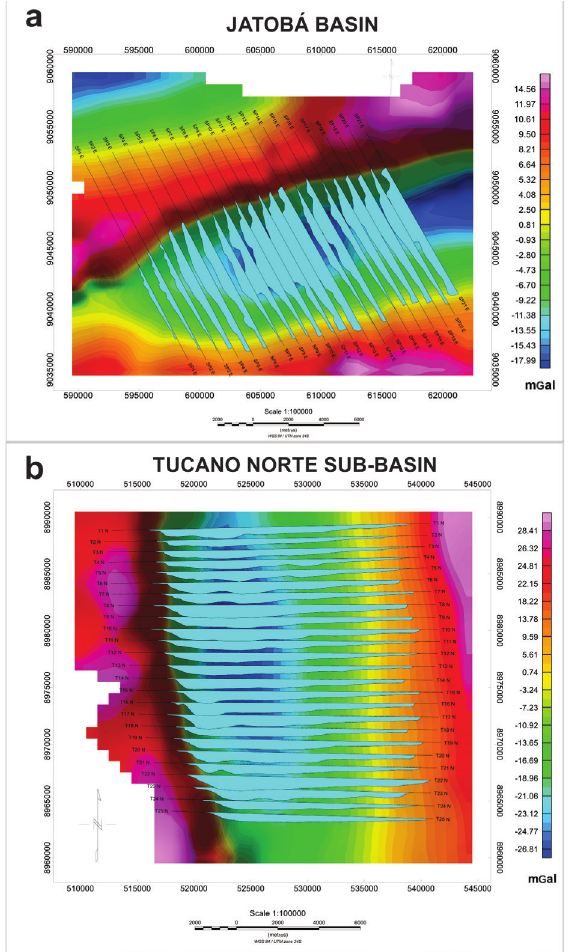
Figure 3. 2D depth profiles of the Jatobá Basin (a) and Tucano Norte Sub-basin